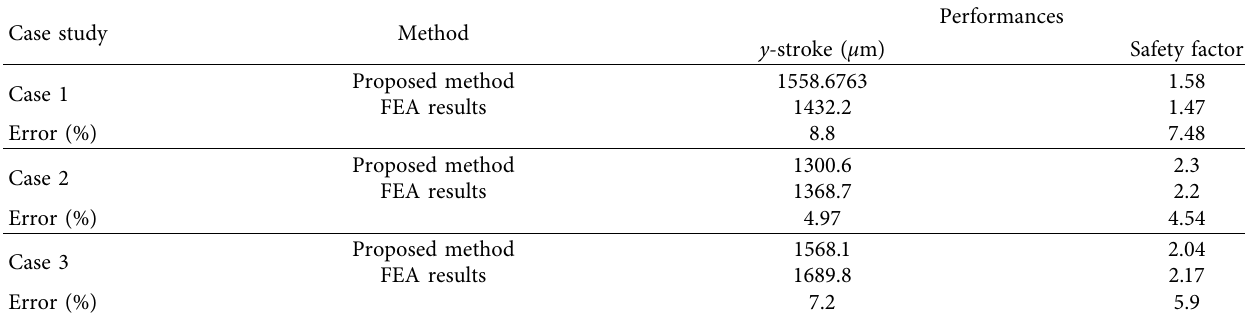
Table 9: Validation